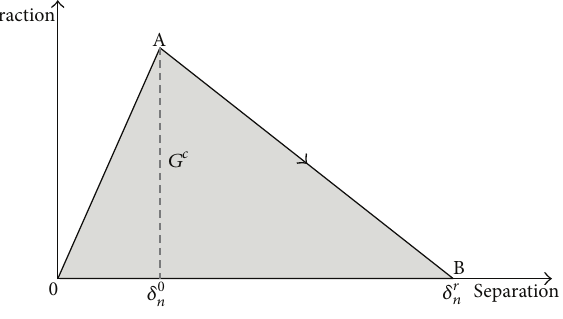
Figure 2: Equivalent stress versus equivalent displacement.